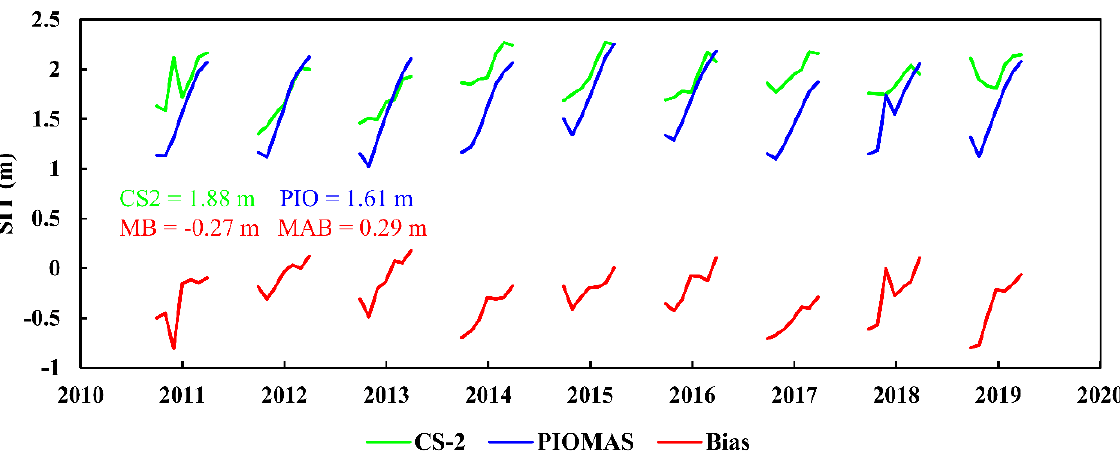
Figure 2. The monthly average Arctic SIT and the mean bias (PIOMAS–CS2) between PIOMAS and CS2 during the sea ice growth season in 2010–2019. The mean SIT for PIOMAS and CS2 and the mean (absolute) bias are listed in Figure 2. The sea ice extent used to calculate the SIT mean value is the entire Arctic Ocean (Figure 1).